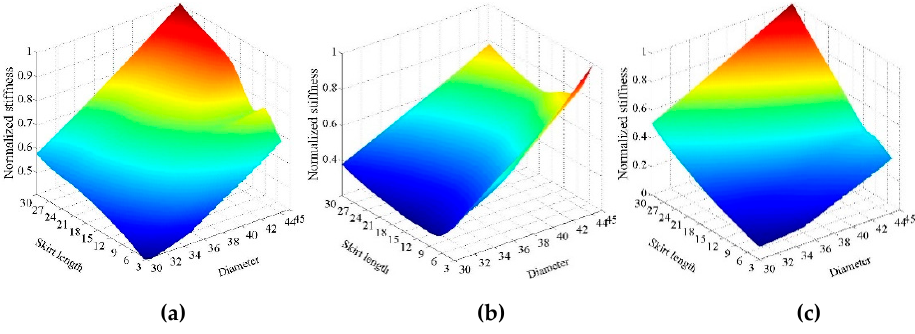
Figure 19. Variation of three dynamic stiffness coefficients at dimensionless excitation frequency of 2: ( a ) Horizontal stiffness; ( b ) coupling stiffness; ( c ) rocking stiffness.